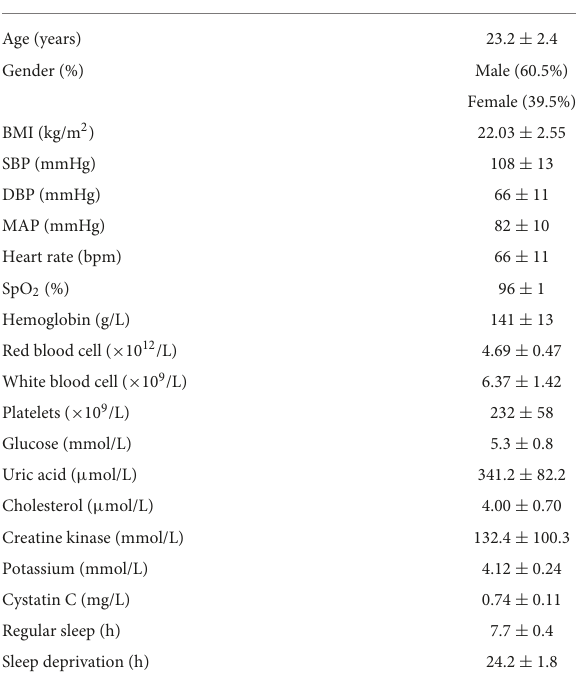
TABLE 1 Demographics and basic clinical characteristics of the study